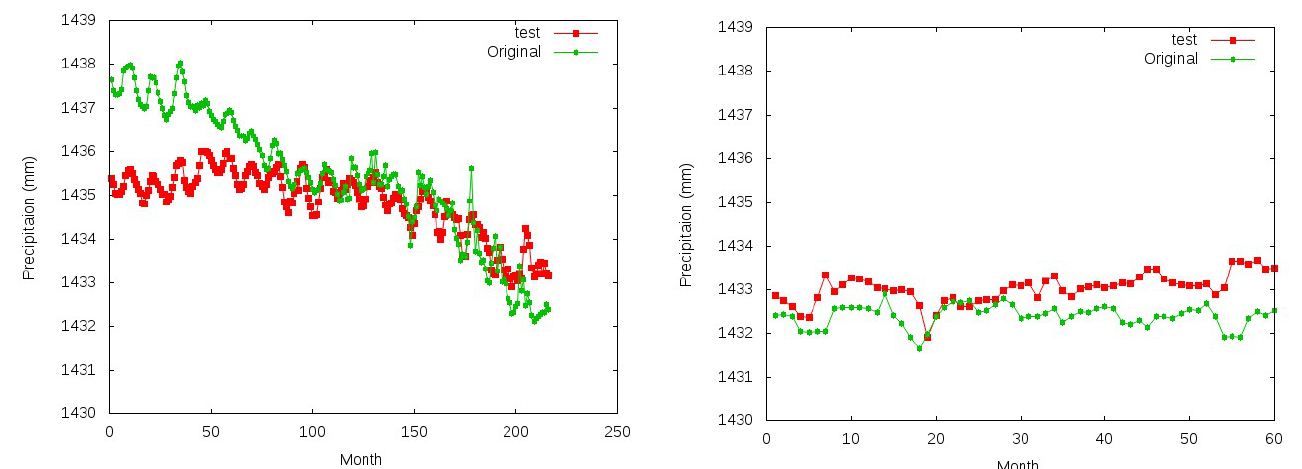
Fig. 4: Test on Back Propagation